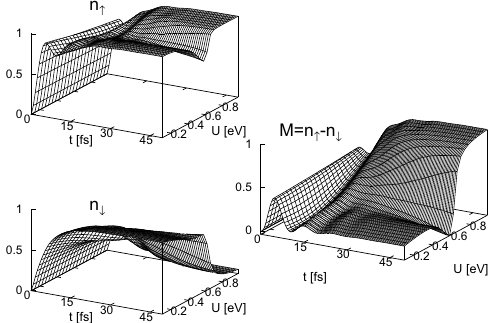
Fig. 3. Island level occupancies and island magnetization as a function of time and of the Coulomb integral (Hubbard U). Only the left lead is turned on.